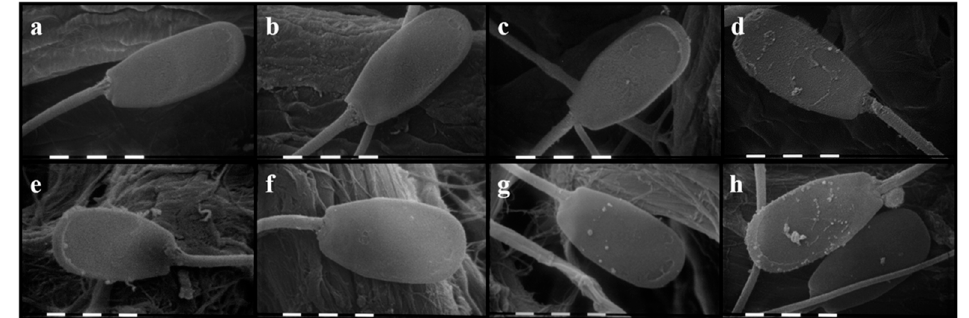
Figure 5. Scanning electron micrographs for the effects of the lowest, middle, and highest concentrations of tea tree oil (TTO) and erpinen-4-ol (TER) on sperm morphology. ( a ) control